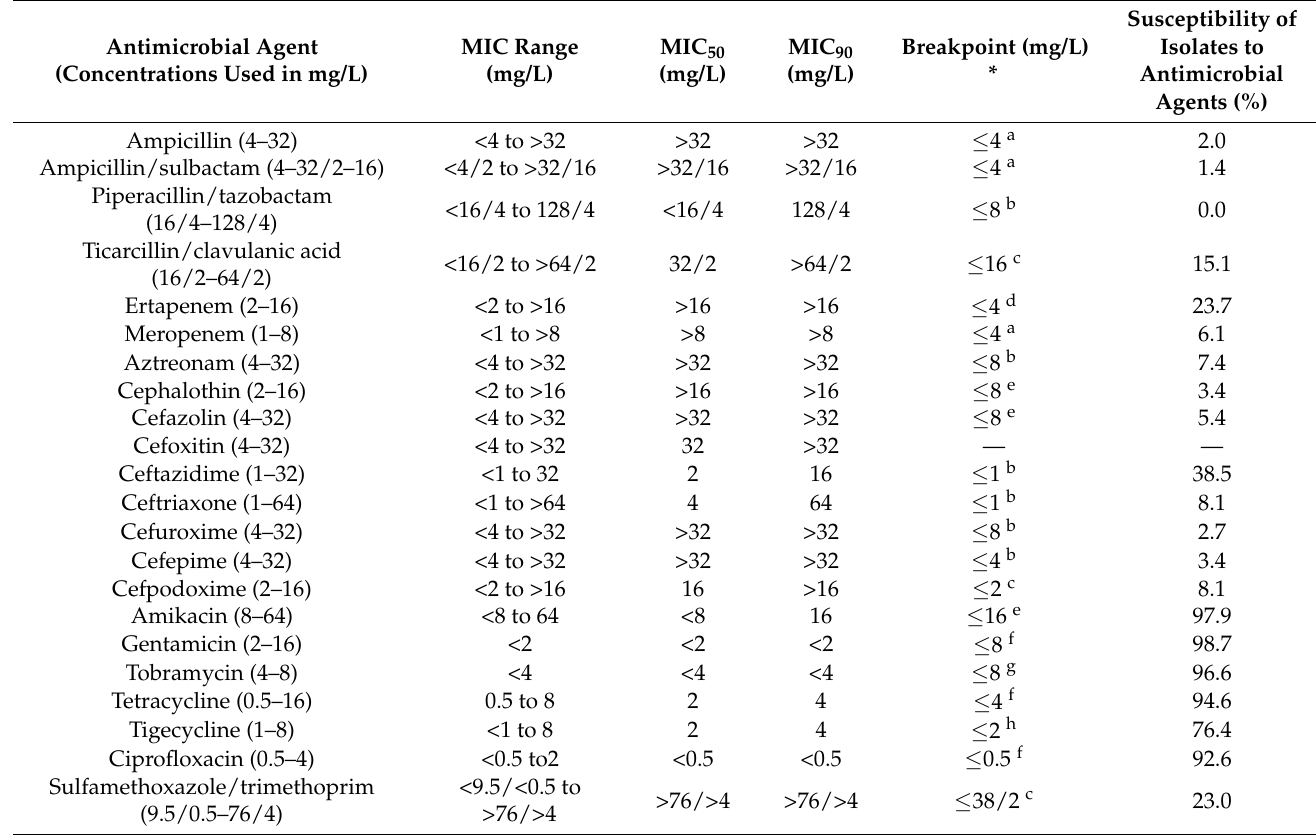
Table 2. Minimum inhibitory concentration (MIC) range, MIC 50 , MIC 90 , and percentage of susceptibility of 29 human Francisella tularensis subsp. holarctica clinical isolates to 22 antimicrobial agents.